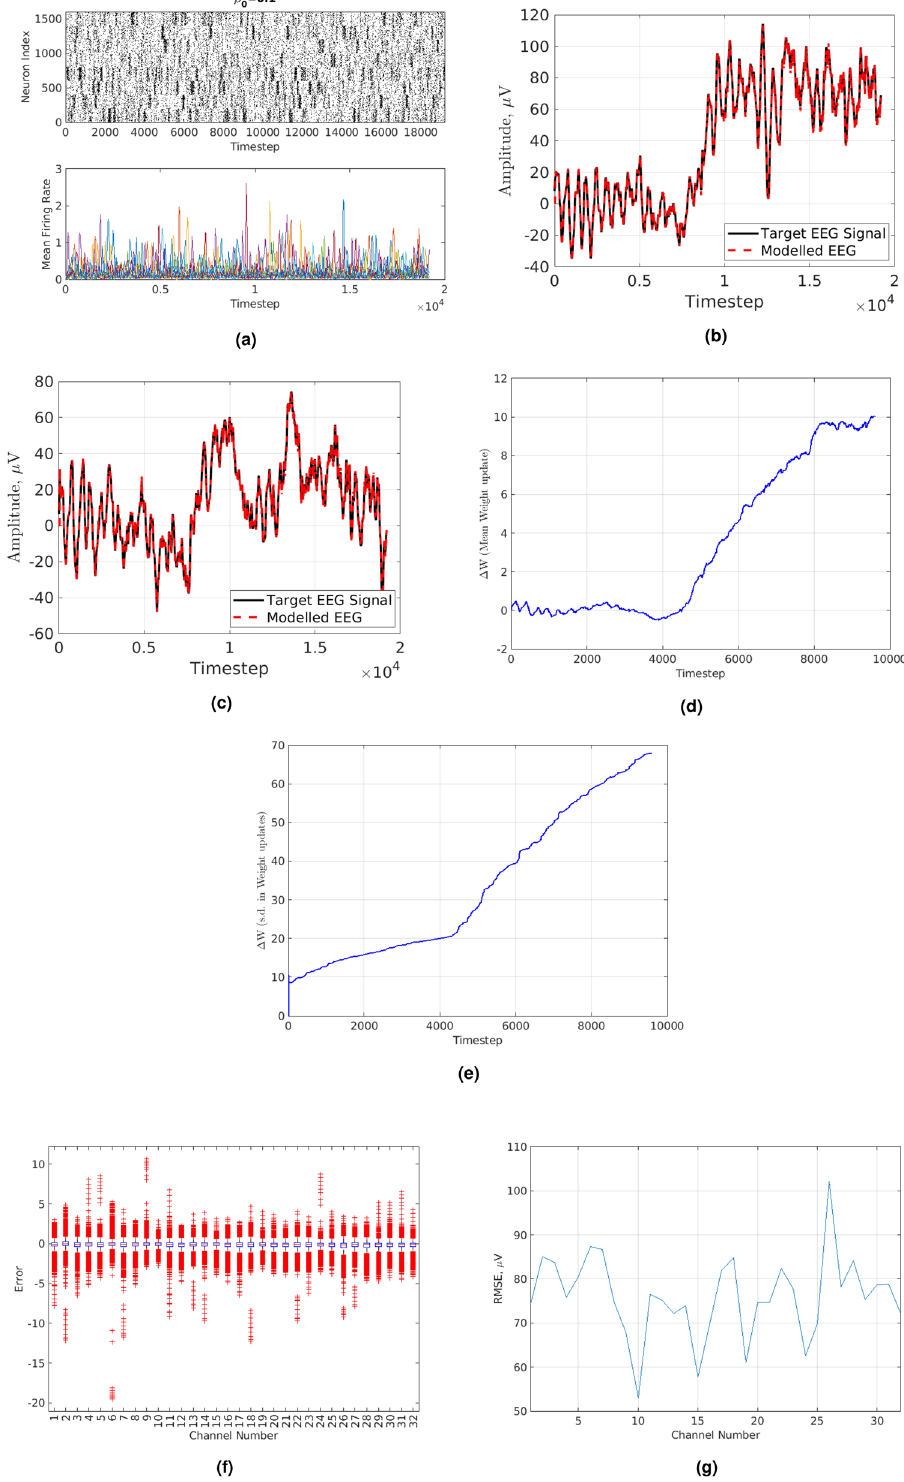
Figure 4. ( a ) Directed topology. Neuronal activity and MFR (raster plot). ( b ) RMSE of directed network for channel 26 using 15 ms conductance delay. Red dashed line shows “Modelled EEG signal”. Black solid line shows “Target EEG signal”. ( c ) Directed biologically-plausible SRNN with max. conductance delay of 15 ms-channel 14. Red dashed line shows “Modelled EEG signal”. Black solid line shows “Target EEG signal”. ( d ) Blue solid line shows Mean Weights update using Directed biologically-plausible SRNN. ( e ) Blue solid line shows s.d. of Weights update using Directed biologically-plausible SRNN. ( f ) Boxplots of error for 32 EEG channels. Red crosses are data points beyond the whiskers. ( g ) Black solid line shows RMSE of directed network for 32 EEG